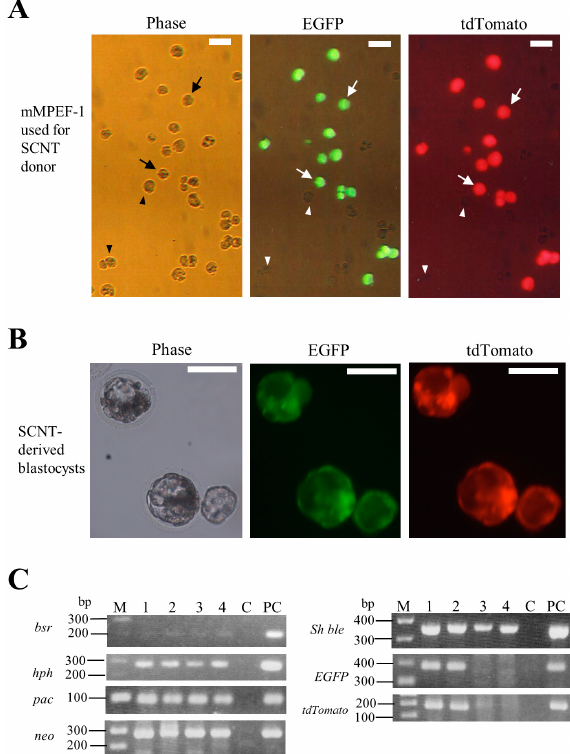
Figure 3. ( A ) Fluorescence micrographs of mMPEF-1 prior to SCNT. Note that there are some cells exhibiting both green and red fluorescence (arrowed), but other cells without any fluorescence (shown by arrowheads) in this clone. Phase, taken under light; tdTomato, red fluorescence derived from tdTomato in pT-tdTomato; and EGFP, green fluorescence derived from EGFP in pT-EGFP. Scale bars = 20 µm; ( B ) fluorescence micrographs of developing blastocysts derived from SCNT using mMPEF-1 as the SCNT donor. Phase, taken under light; tdTomato, red fluorescence derived from tdTomato in pT-tdTomato; and EGFP, green fluorescence derived from EGFP in pT-EGFP. Scale bars = 100 µm; and ( C ) PCR analysis of a single blastocyst derived from SCNT using mMPEF-1 as the SCNT donor. Genomic DNA isolated from each single blastocyst was subjected to WGA prior to PCR analysis. The data shown are the results from the nested PCR. M, 100-bp ladder marker; lanes 1 and 2, blastocysts showing both red and green fluorescence; lanes 3 and 4, blastocysts showing no fluorescence; lane C, normal PEFs; lane PC, control plasmids (pT-neo for detection of neo ; pT-pac for detection of pac ; pT-hph for detection of hph ; pT-Sh ble for detection of Sh ble ; pT-bsr for detection of bsr ; pT-EGFP for detection of EGFP cDNA; pT-tdTomato for detection of tdTomato cDNA).